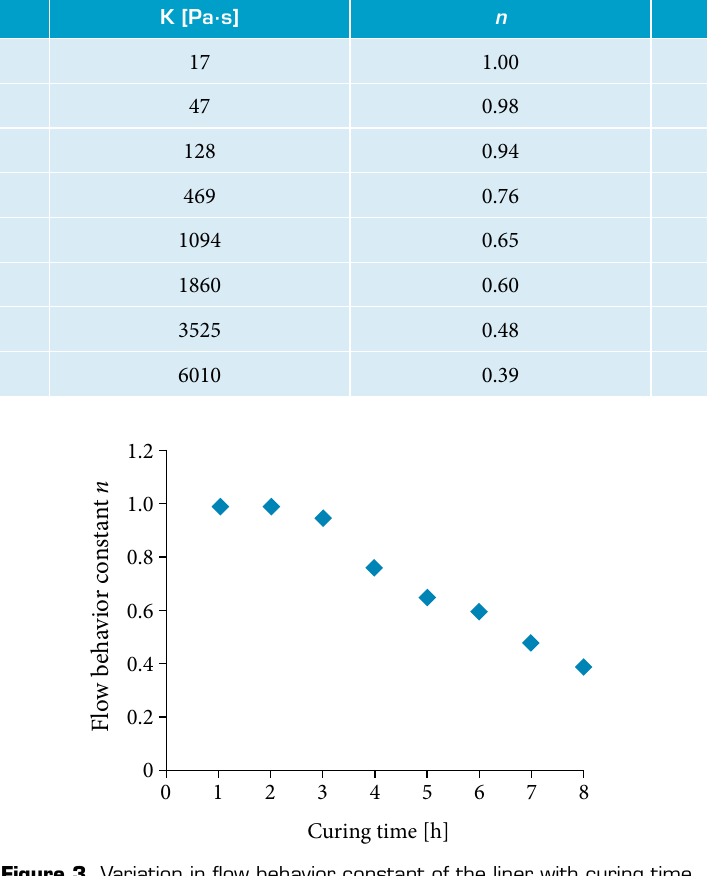
Figure 3. Variation in flow behavior constant of the liner with curing